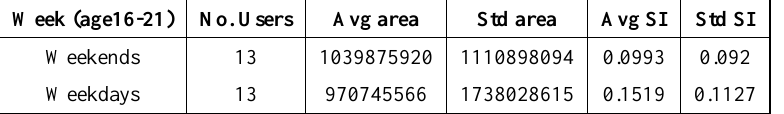
Table 5. Average and standard deviation of area and shape index of users between 16-21 based on days of the week.